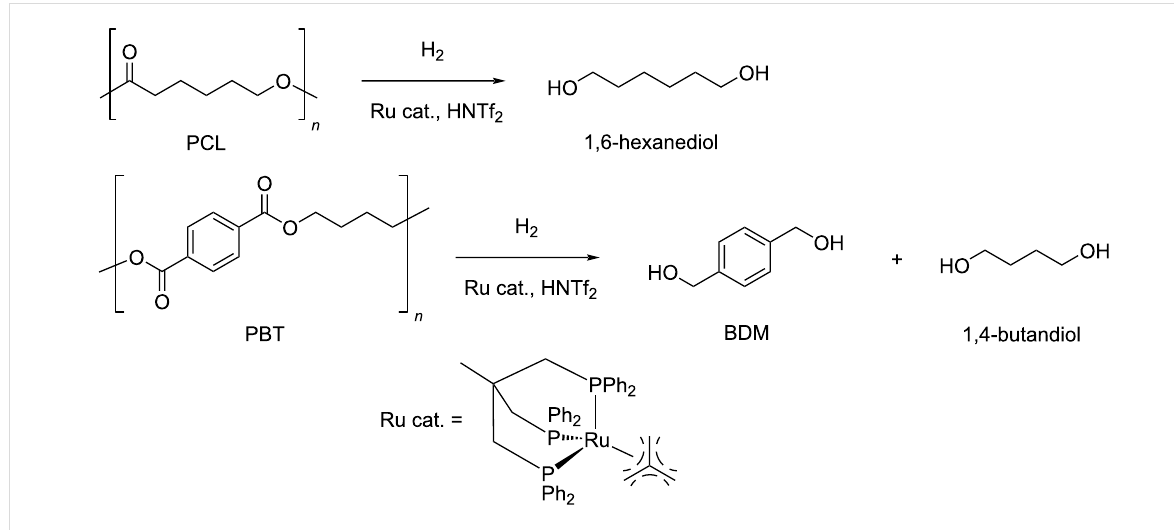
Scheme 14: Hydrogenative depolymerisation of PBT and PCL by molecular Ru catalysts.